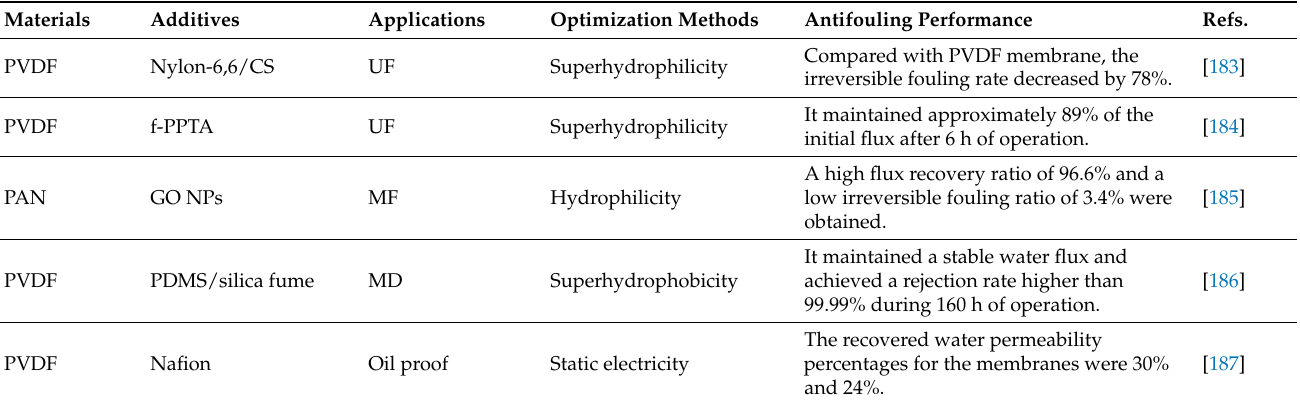
Table 5. Research on antifouling performance based on